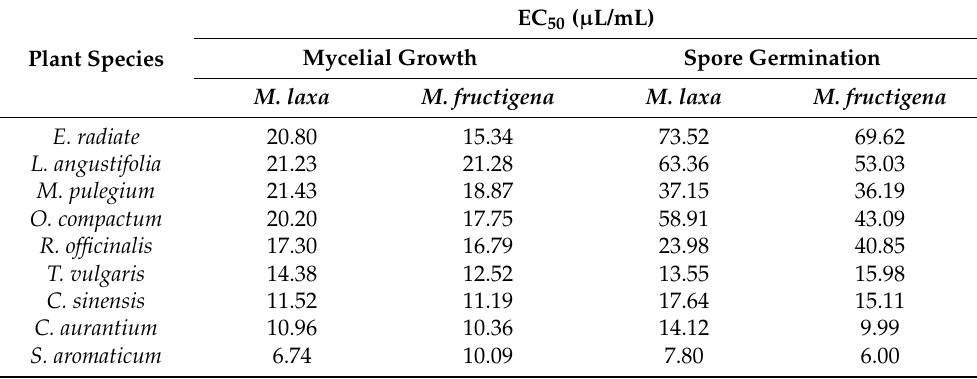
Table 2. EC 50 values corresponding to 50% inhibition of mycelial growth and spore germination.